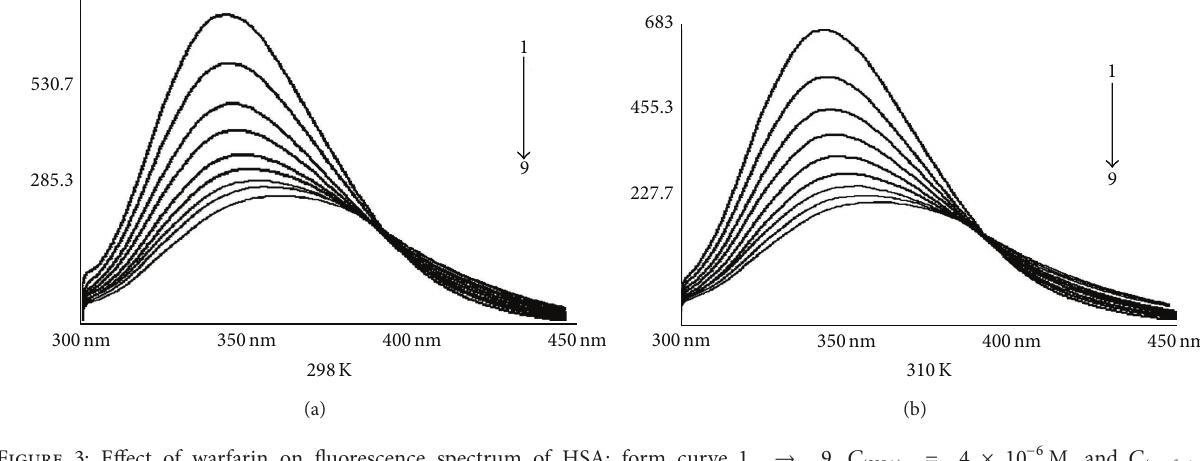
= 4 × 10 −6 M, and 𝐶 = ( warfarin ) HSA )